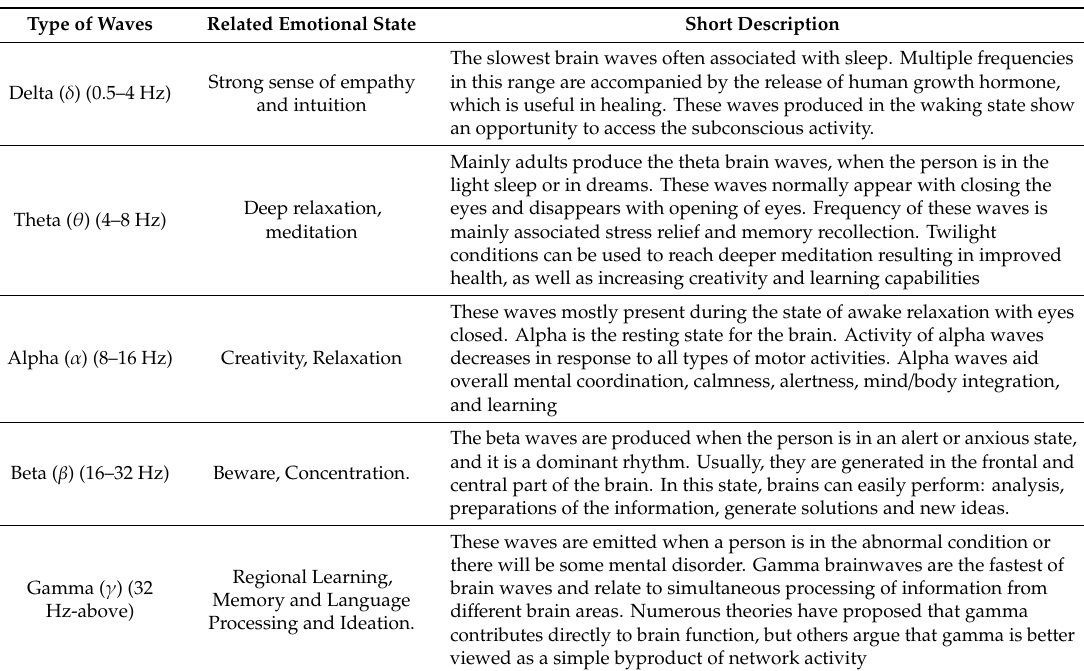
Table 1. Classification of brain waves [47,48].